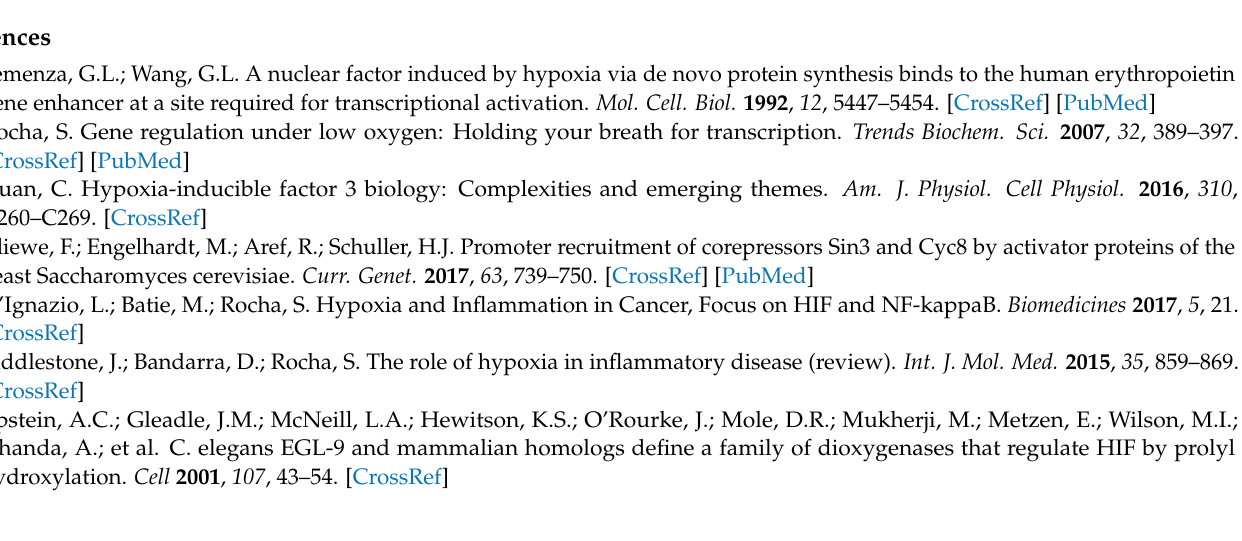
assays; Supplementary Table S2: Known mutations in the hypoxia signalling system in humans, and Supplementary Table